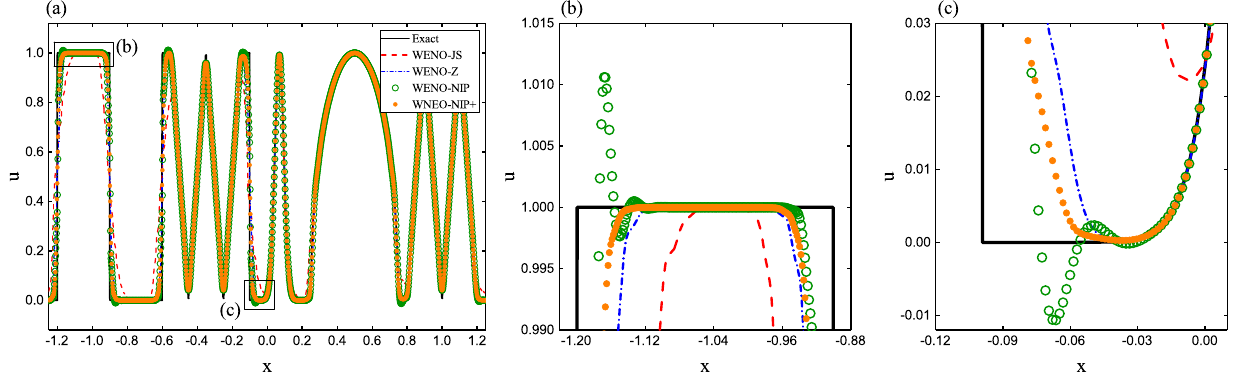
Figure 7. ( a ) Results of the ZWACM linear test with t = 200 (80 cycles) and N = 1600. ( b ) Zoomed-in view of the top of the square wave. ( c ) Zoomed-in view of the concerned region as marked in ( a ).